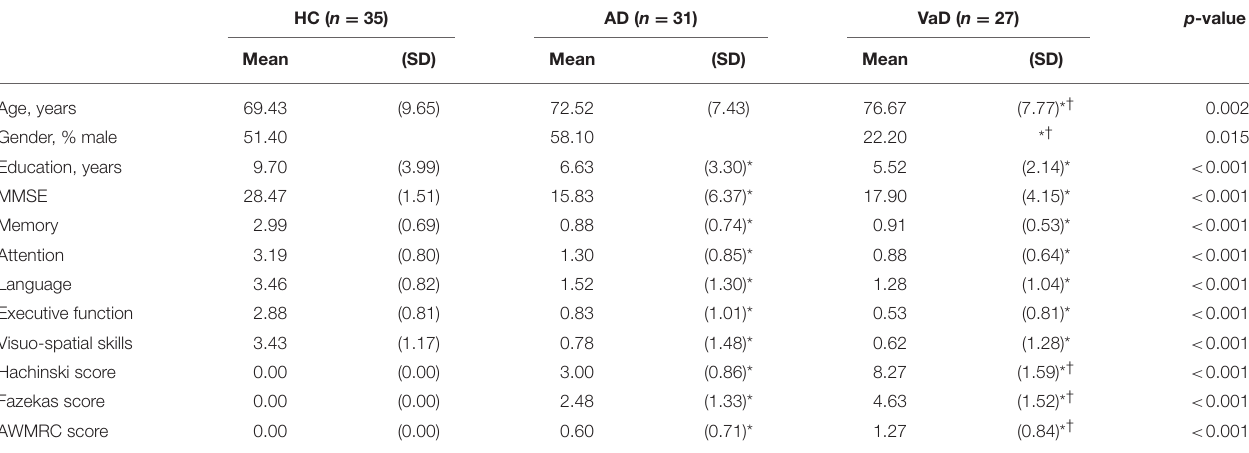
TABLE 2 | Demographic and clinical evaluation.